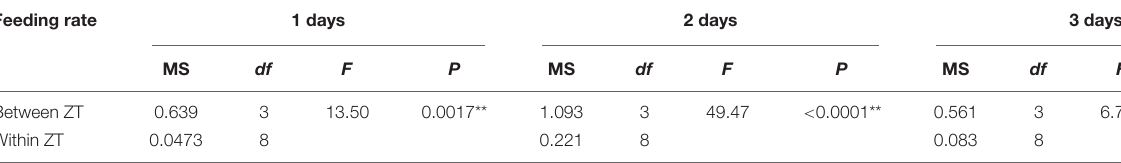
TABLE 2 | Results of one-way ANOVA analysis of feeding rate under the diurnal cycle. Feeding rate 1 days 2 days